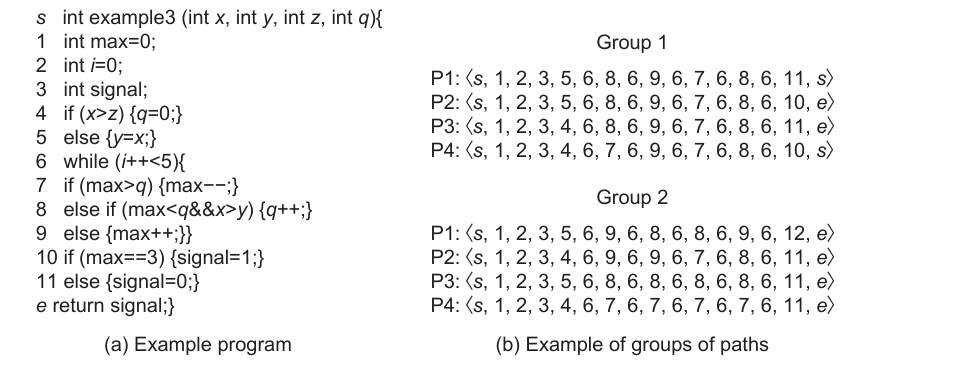
Fig. 3 Example of a program and some of its groups. Algorithm 2